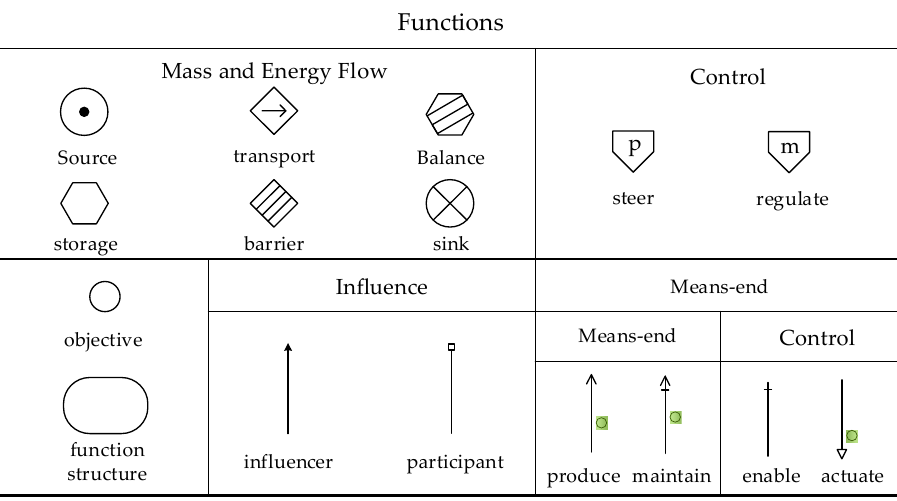
Figure 3. Elements of MFM.